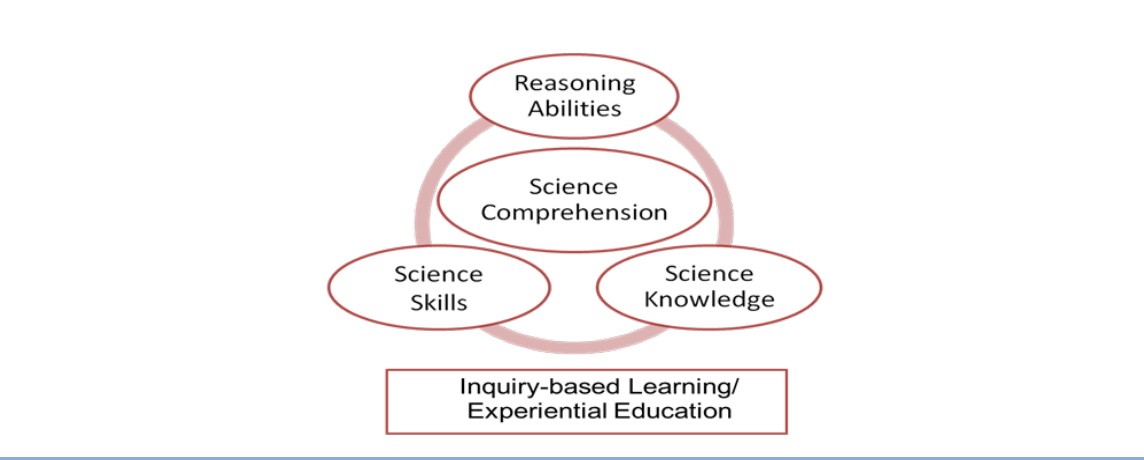
Figure 1. YASC Conceptual Model for Improving Youth Science